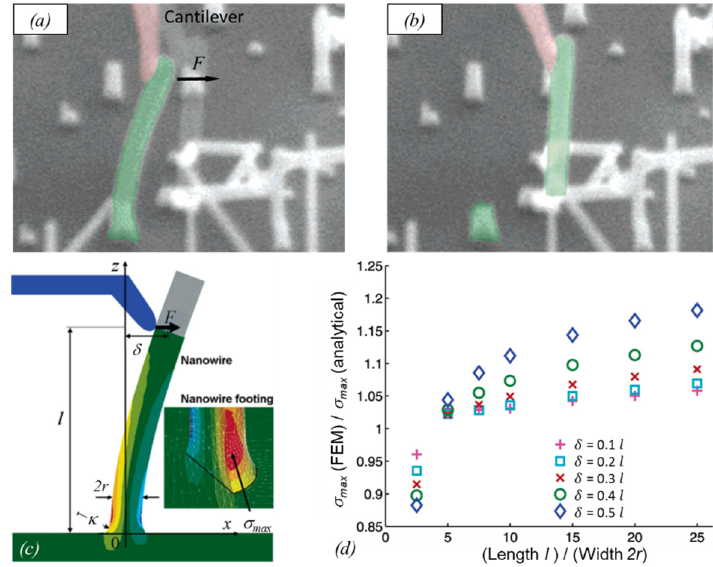
Figure 7. Bending fracture experiment with silicon nanowires inside an SEM. A cantilever (shaded red) bends a pillar (shaded green) laterally ( a ) until it finally breaks off ( b ). ( c ) Finite element simulations of the curved foot base of a pillar. Geometry of bending experiment and foot base with a curvature κ = 10 − 2 nm − 1 . Largest tensile (red) and compressive (blue) stresses occur above the substrate–pillar interface. ( d ) Deviations due to curved foot base with respect to Equation (12), which assumes idealized uniform cylinder geometry. Modified from Hoffmann et al. [89] .